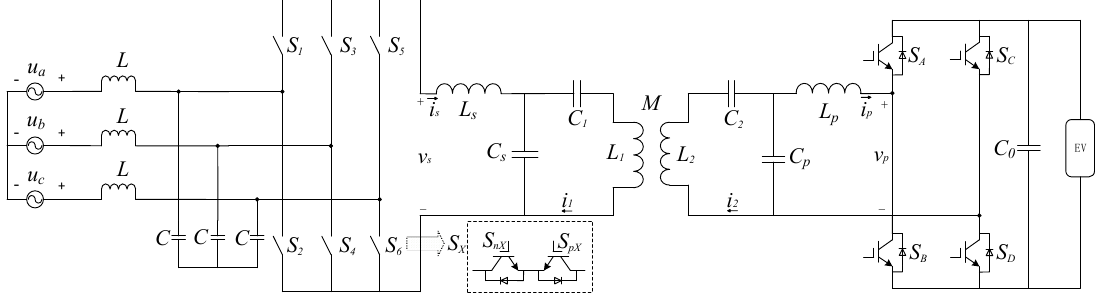
Figure 1. Electric vehicle wireless charging system based on direct three-phase AC–AC matrix converter.